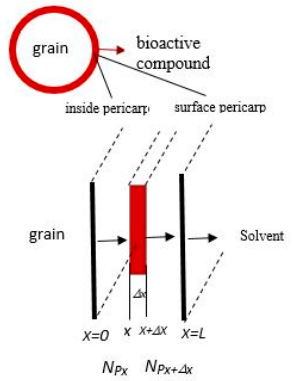
Figure 1. Schematic of bioactive compound mass transfer from pericarp to solvent.